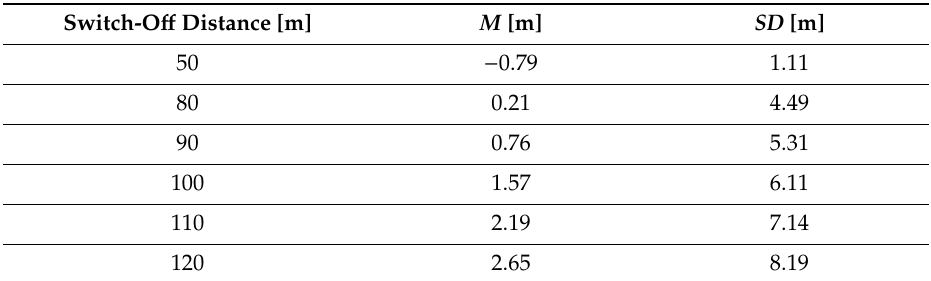
Table 1. Mean and standard deviation of the distance di ff erences of the AV and the implemented manual vehicle using each speed profile (o ff ensive, neutral, defensive) once ( n = 3). The distance to the road bottleneck when the detail synchronization was switched o ff was varied.